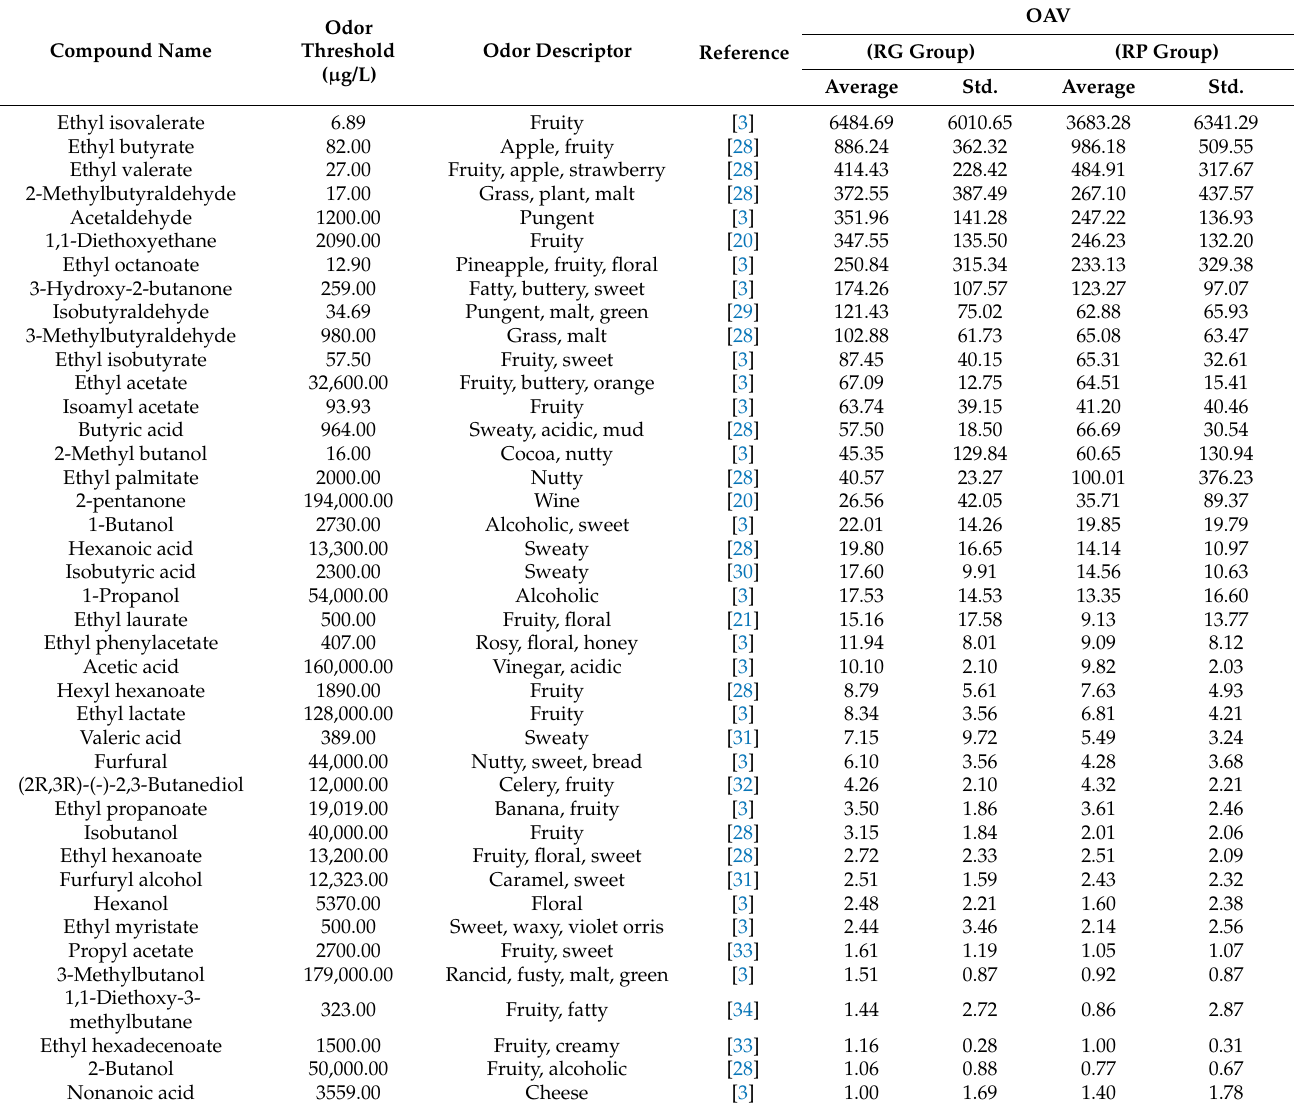
Table 1. Aroma compounds detected in SABs with OAV higher than